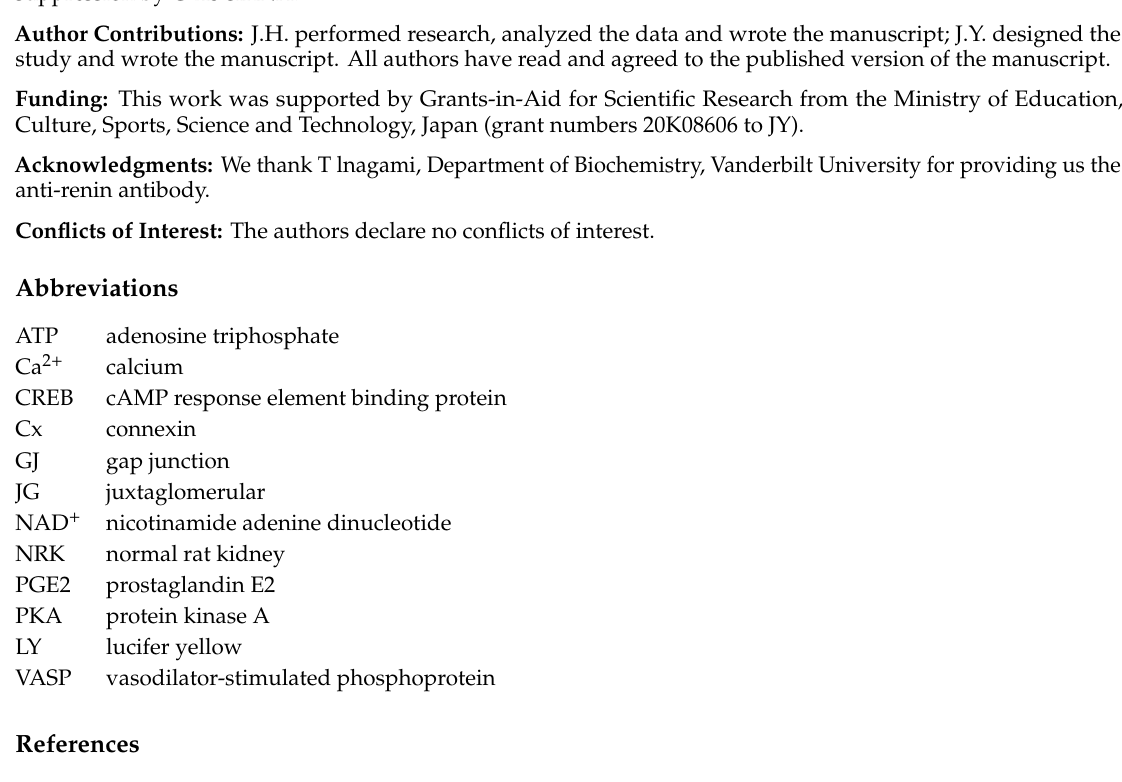
Figure S1: E ff ects of treatment of As4.1 cells with siRNA against distinct Cx molecule on Ca 2 + deprivation-induced phosphorylation of CREB. As4.1 cells were treated with the indicated siRNA against Cx37, 40, 43 and 45 for 24 h. After that, they were exposed to Ca 2 + -free medium for 30 min. Cellular protein was extracted and subjected to Western blot analysis for the e ff ectiveness of Cx43 siRNA in downregulation of Cx43 protein level (A) and phosphorylated CREB (B). Note the elevation of p-CREB following removal of extracellular Ca 2 + and its suppression by Cx43